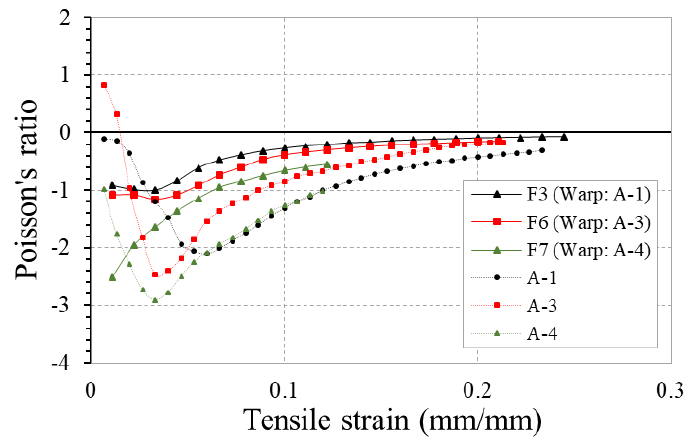
Figure 17. PR-tensile strain curves of fabrics F3, F6, F7 and their respective 4-ply auxetic yarns.